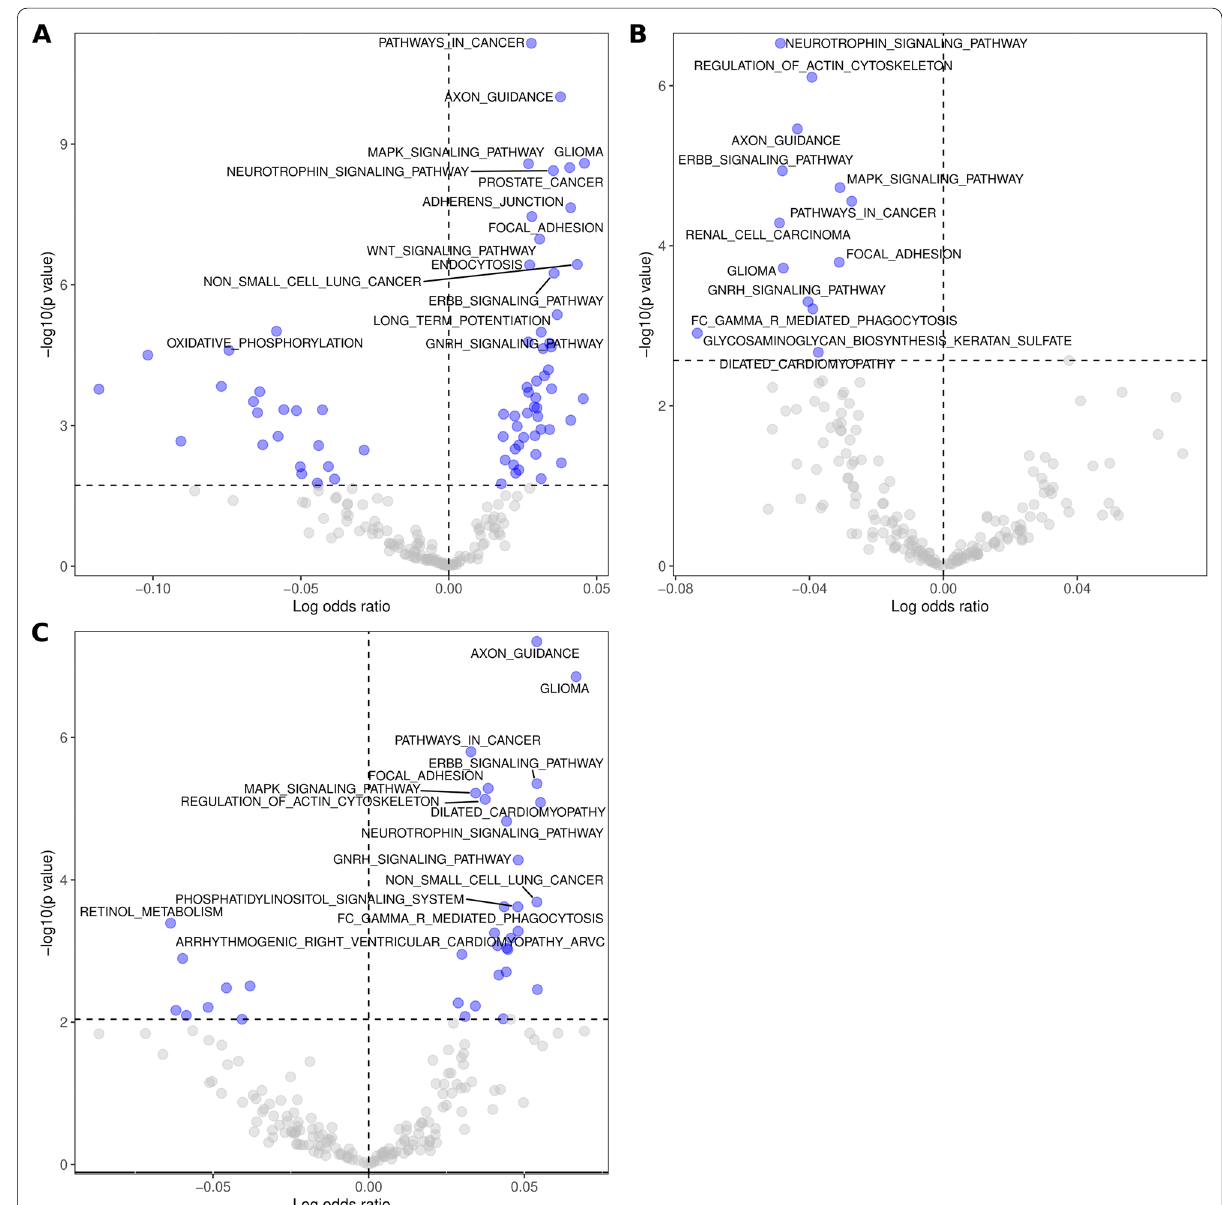
Fig. 2 Results of the KEGG enrichment analysis among the targets of differentially expressed miRNAs in plasma ( A ), extracellular vesicles ( B ), and between the compartments ( C